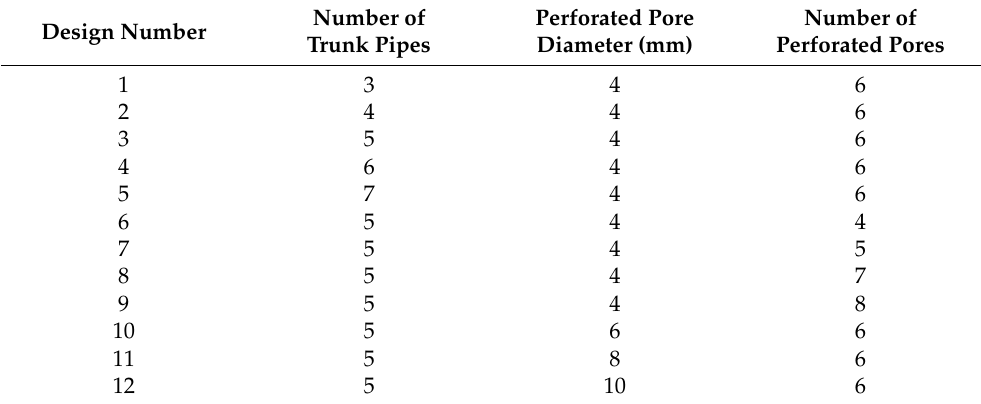
Table 2. Parameters of different water diffuser